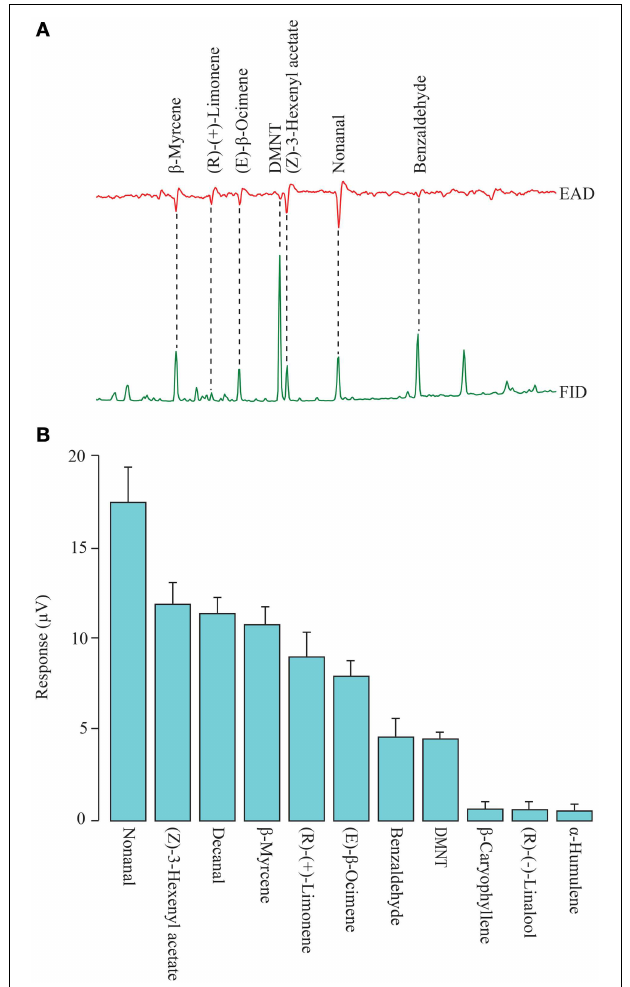
FIGURE 1 | (A) Representative trace of the antennal response of mated Spodoptera littoralis females to natural cotton headspace extracts that were tested in the flight tunnel. FID, flame ionization detector; EAD, electroantennographic detection. (B) Antennal response for GC-EAD recordings ( N = 8 –10) in female moths. Bars represent 1 standard